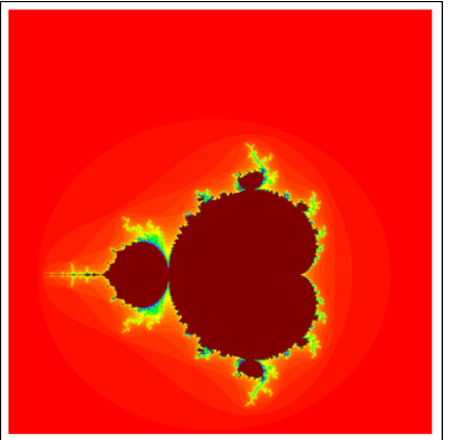
Figure 26. M-set of degree 2 via F-iterative scheme with image visual time = 87.8 s.